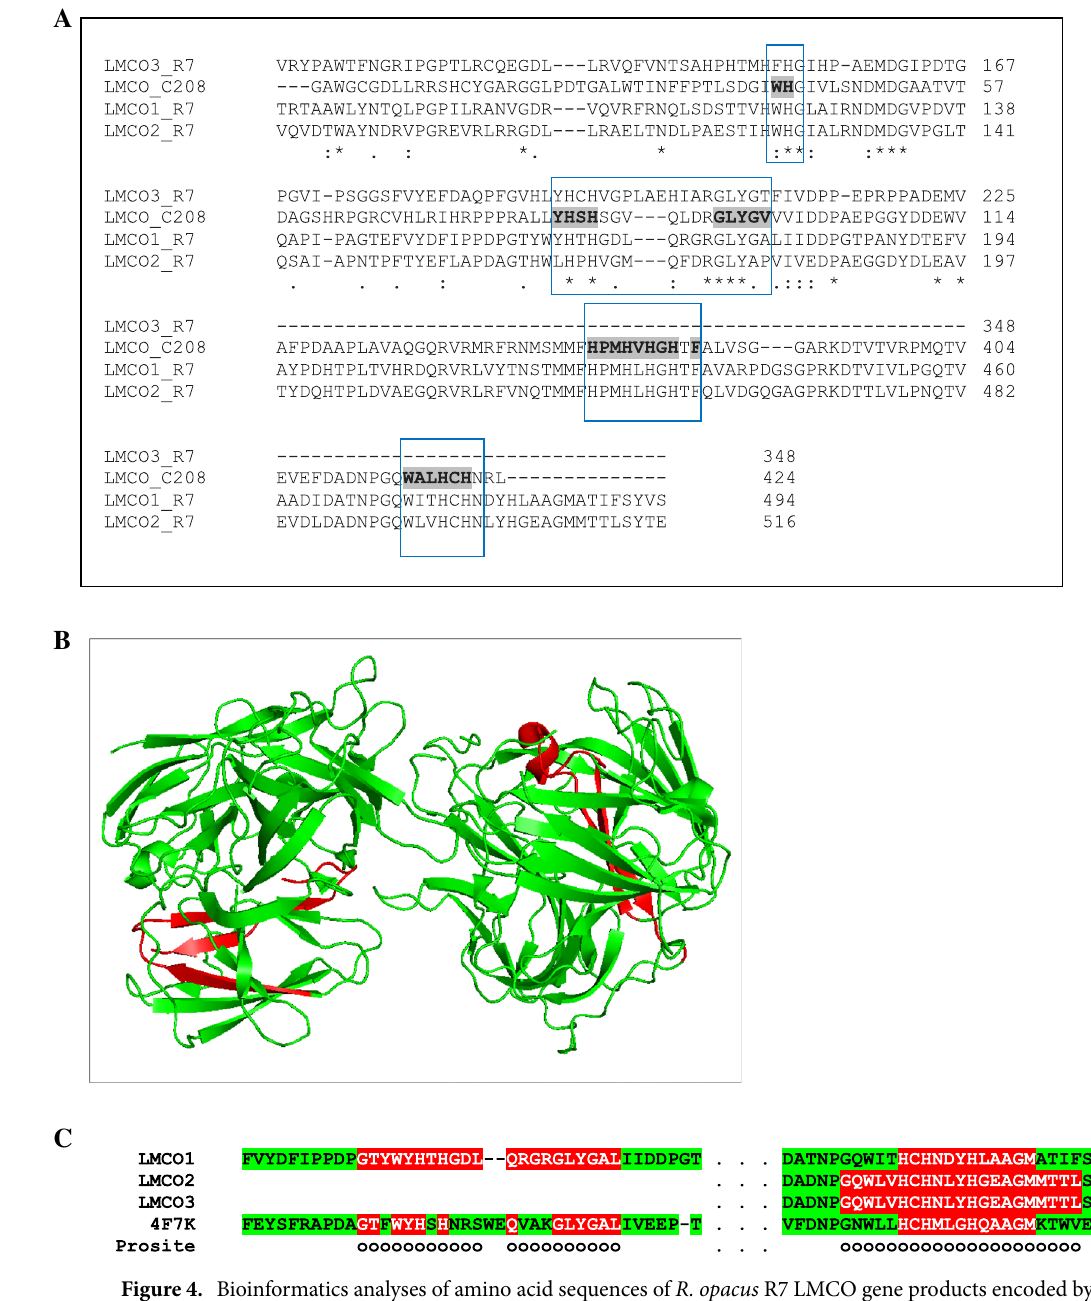
Figure 4. Bioinformatics analyses of amino acid sequences of R. opacus R7 LMCO gene products encoded by LMCO1, 2, and 3 DEGs. Multiple alignment of LMCO1, 2, and 3 amino acid sequences with respect to R . ruber C208 LMCO sequence evidencing putative copper-binding motifs generally associate to the class of laccases (rectangular area); bold grey amino acids correspond to the copper-binding motifs reported for C208 sequence 22 ( A ). Protein structure of Lac15 from a marine microbial metagenome (PDB 4F7K) showing in red color the laccase domain regions ( B ). Multiple alignment of the conserved domain region of 4F7K sequence respect with LMCO1, 2, and 3 amino acid sequences according to EFICAz software and PROSITE ( C